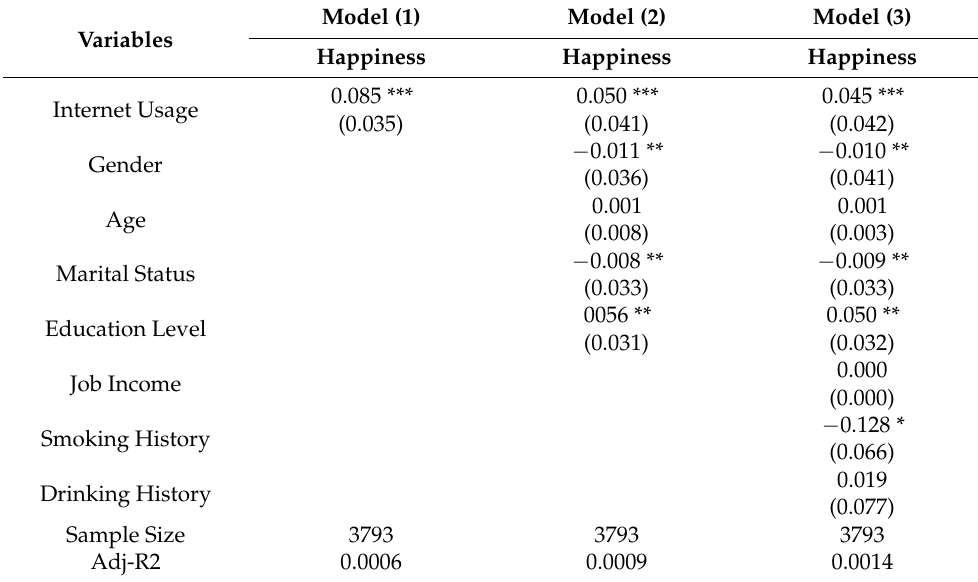
Table 3. Baseline regression results of Internet use on civil servants’